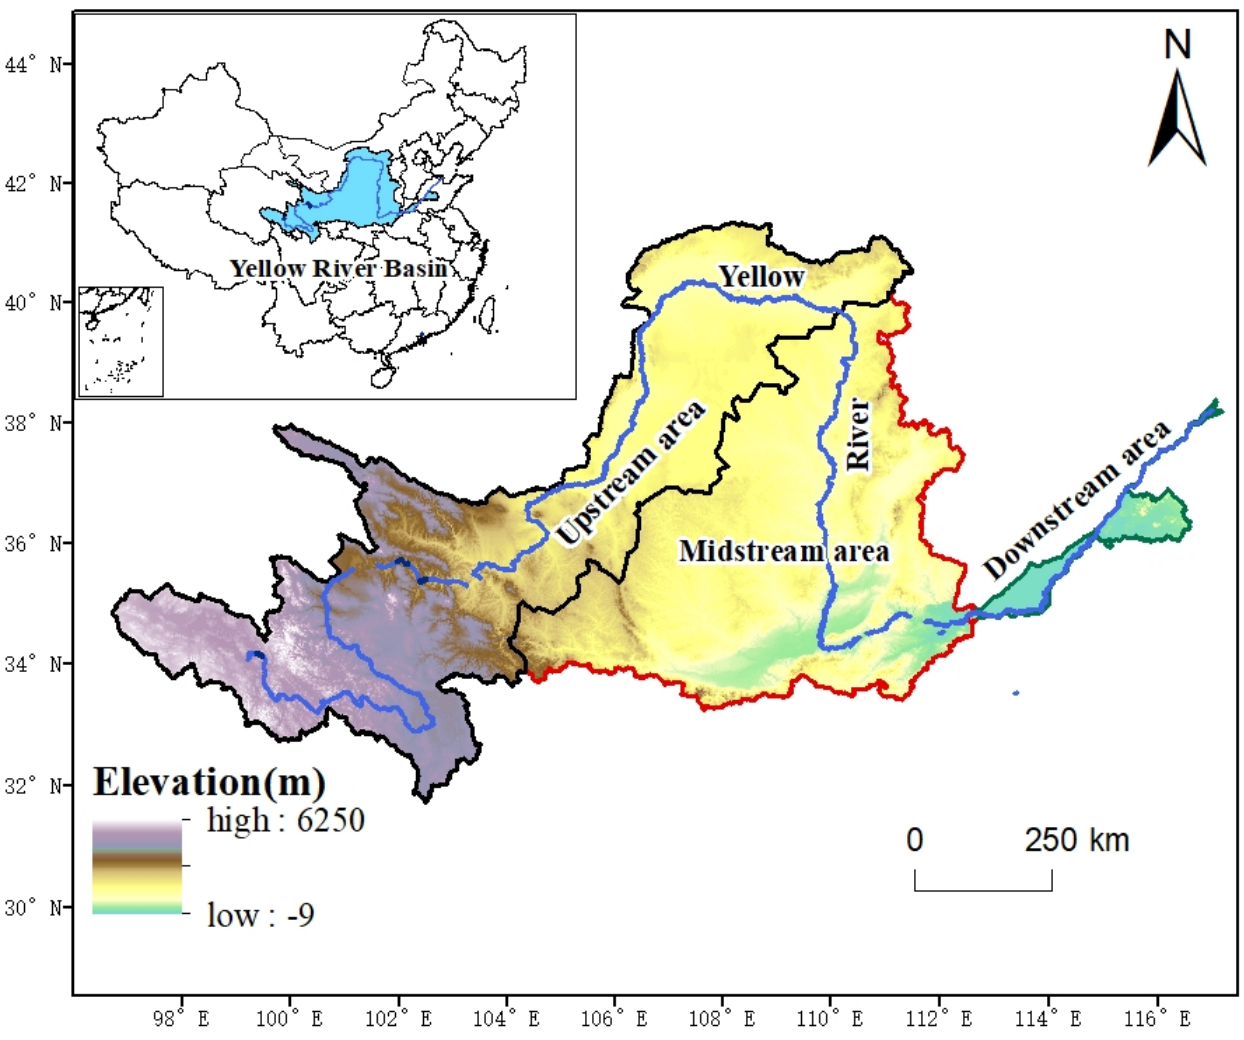
Figure 1. Spatial location and DEM of the Yellow River Basin (YRB).